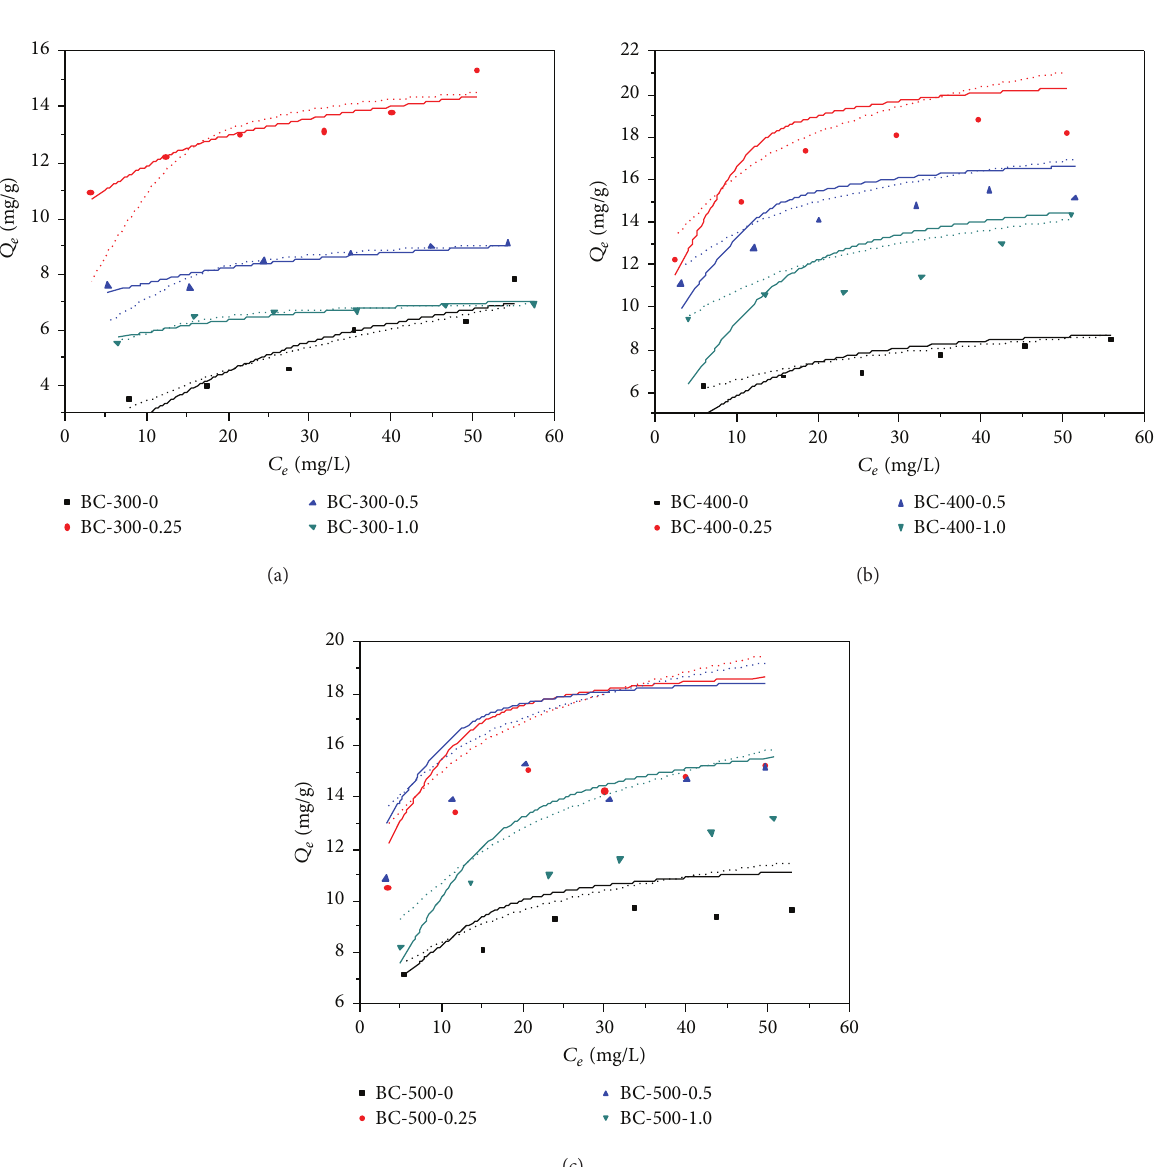
Here, 𝑄 𝑒 represents the absorption amount (mg/g); 𝐶 𝑒 rep- resents the equilibrium concentration (mg/L); 𝑄 𝑚 represents the maximum sorption capacity (mg/g); 𝐾 L represents the Langmuir sorption constant; and 𝐾 F and 1/𝑛 are the Fre- undlich constants.